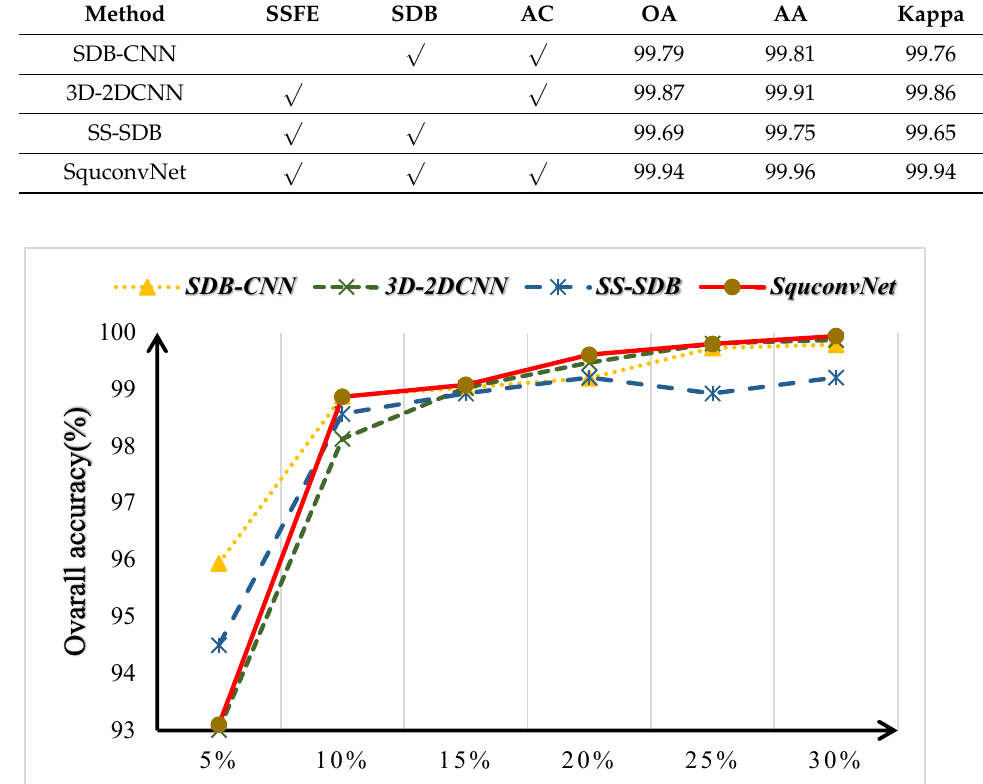
Figure 11. The Overall Accuracy of the different proposed models on the IP dataset at different training samples.